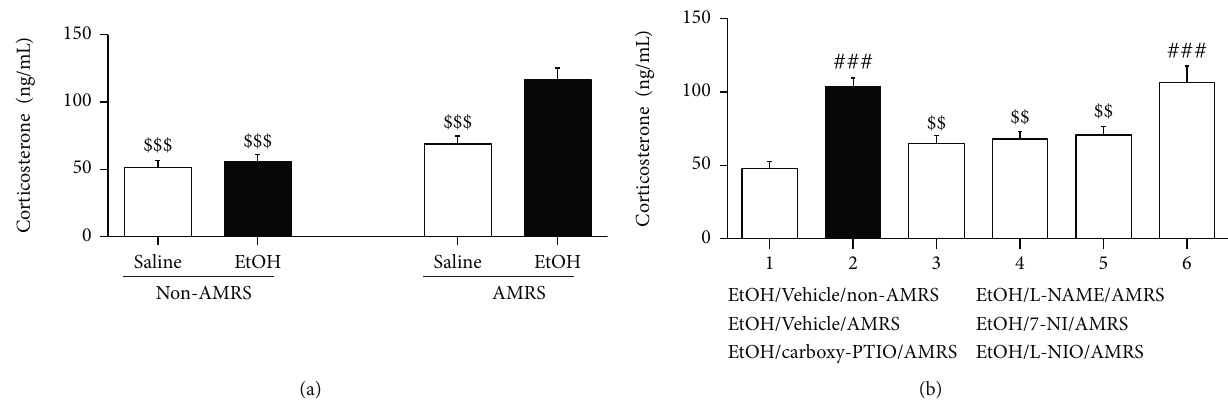
Figure 3: E ff ects of carboxy-PTIO, L-NAME, 7-NI, and L-NIO on AMRS-induced plasma CORT secretion. Data are expressed as mean ± SEM ( n = 6 ). ### p < 0 : 001 versus saline/vehicle/non-AMRS group; $$$ p < 0 : 001 versus EtOH/AMRS group or EtOH/vehicle/AMRS